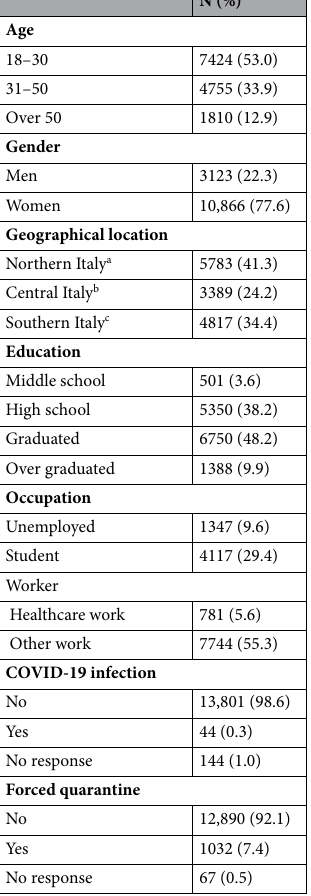
Table 4. Demographic characteristics of the sample. a Northern Italy: Aosta Valley, Emilia Romagna, Friuli- Venezia Giulia, Liguria, Lombardy, Piedmont, Trentino-Alto Adige, and Veneto. b Central Italy: Lazio,